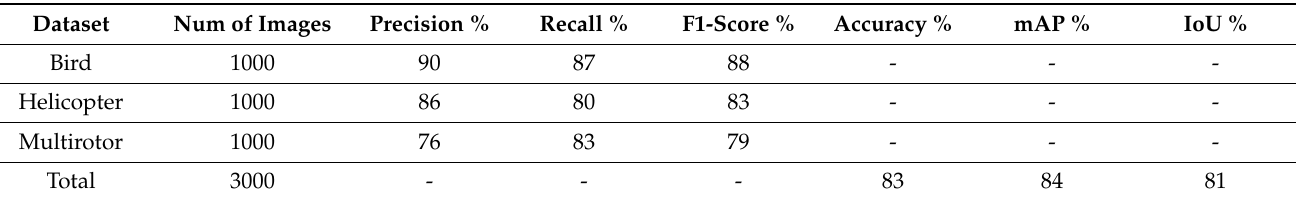
Table 1. Evaluation results of the